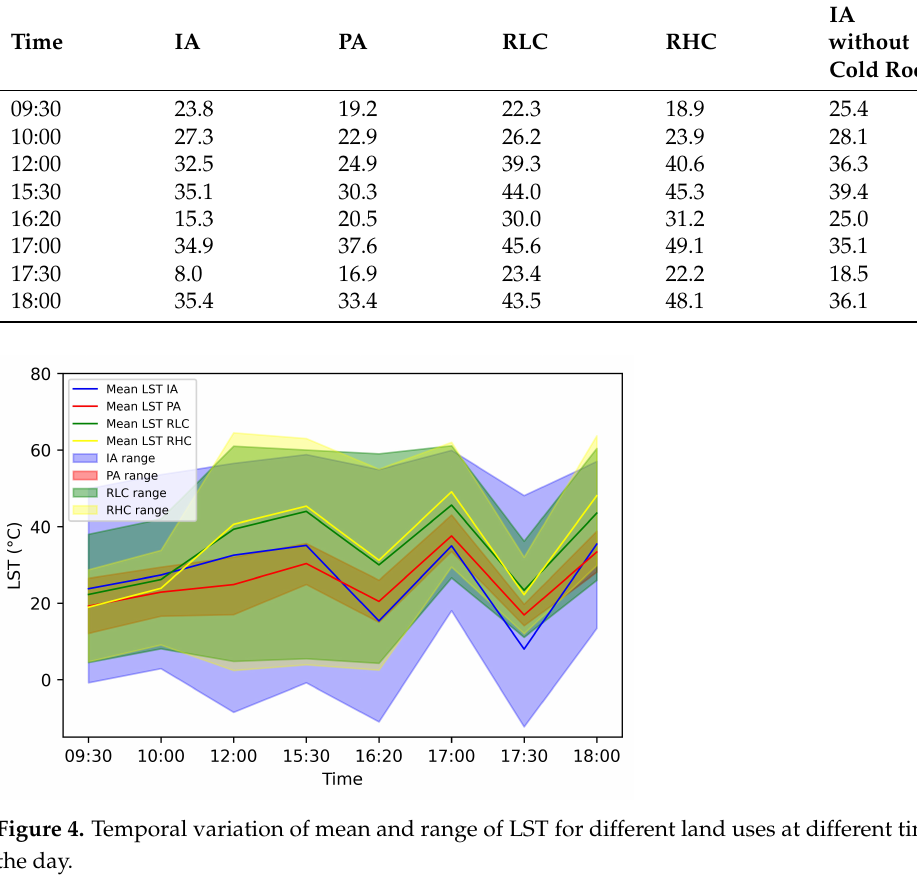
Table 6. Mean LST ( ◦ C) in each LU for 8 flights in September and October 2022.